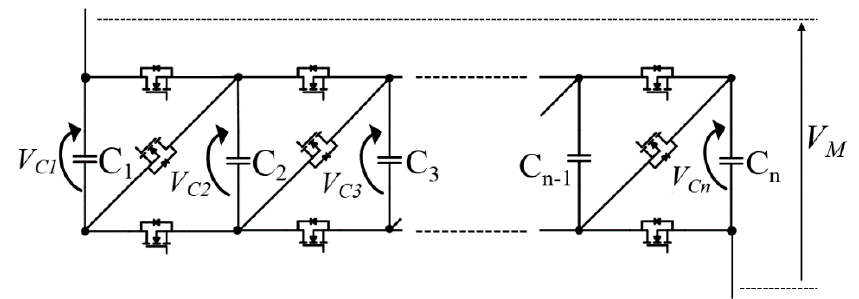
Figure 8. Proposed series-parallel reconfiguration circuit for n